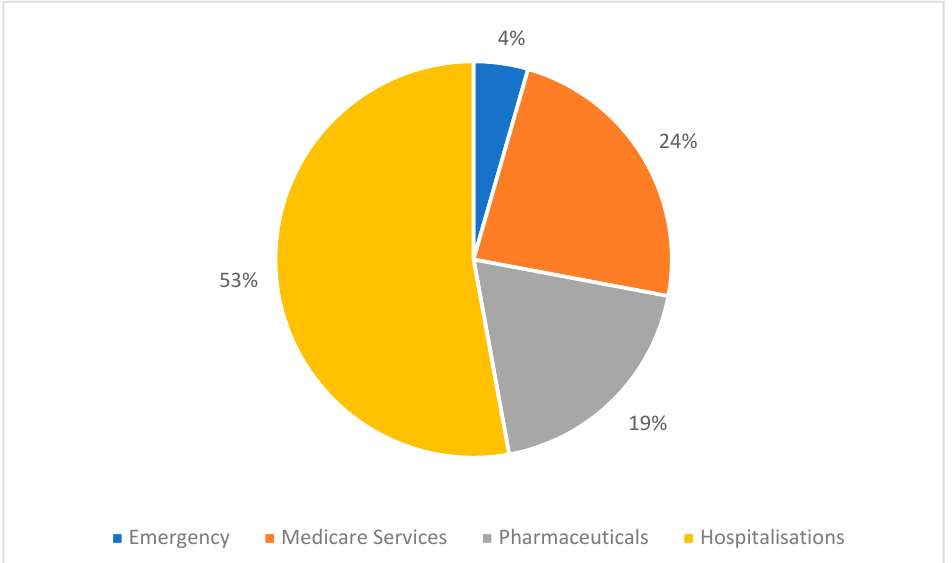
Figure 8. Cumulative mean annual healthcare cost (2013–2016) in AU$ for the cancer cohort by type of cancer and health service component (N = 230,380).